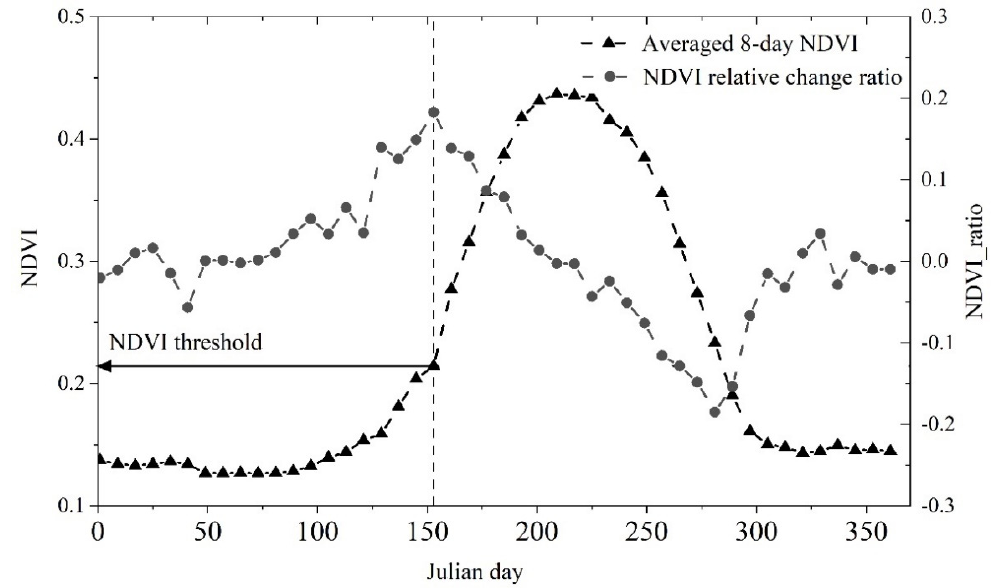
Figure 2. Schematic figures for calculating NDVI thresholds based on relative rates of change for NDVI time series. NDVI value of each point is mean value of grassland on Tibetan Plateau.